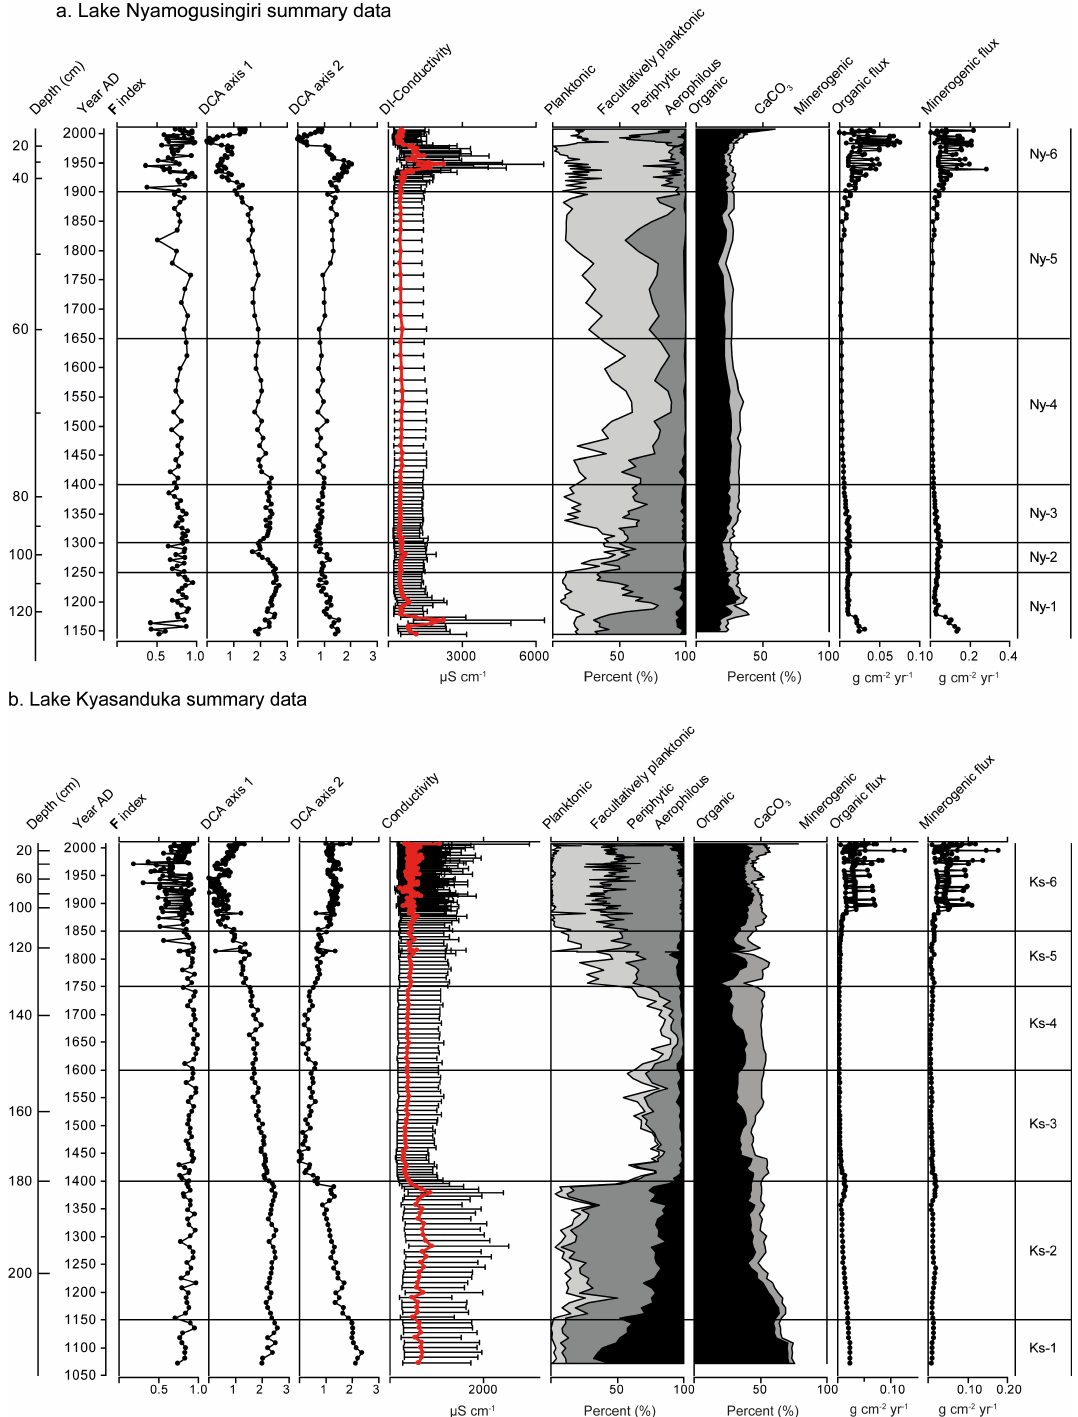
Figure 5. Summary information from the (a) Lake Nyamogusingiri and (b) Lake Kyasaduka sediment cores, including the F index (diatom valve preservation; Ryves et al., 2001), DCA axes 1 and 2 sample scores, and the diatom-inferred (DI) conductivity (red line) and associ- ated jack-knife error (RMSEP = 0.256 log units) alongside a diatom habitat summary and the results of LOI and calculated organic and minerogenic flux